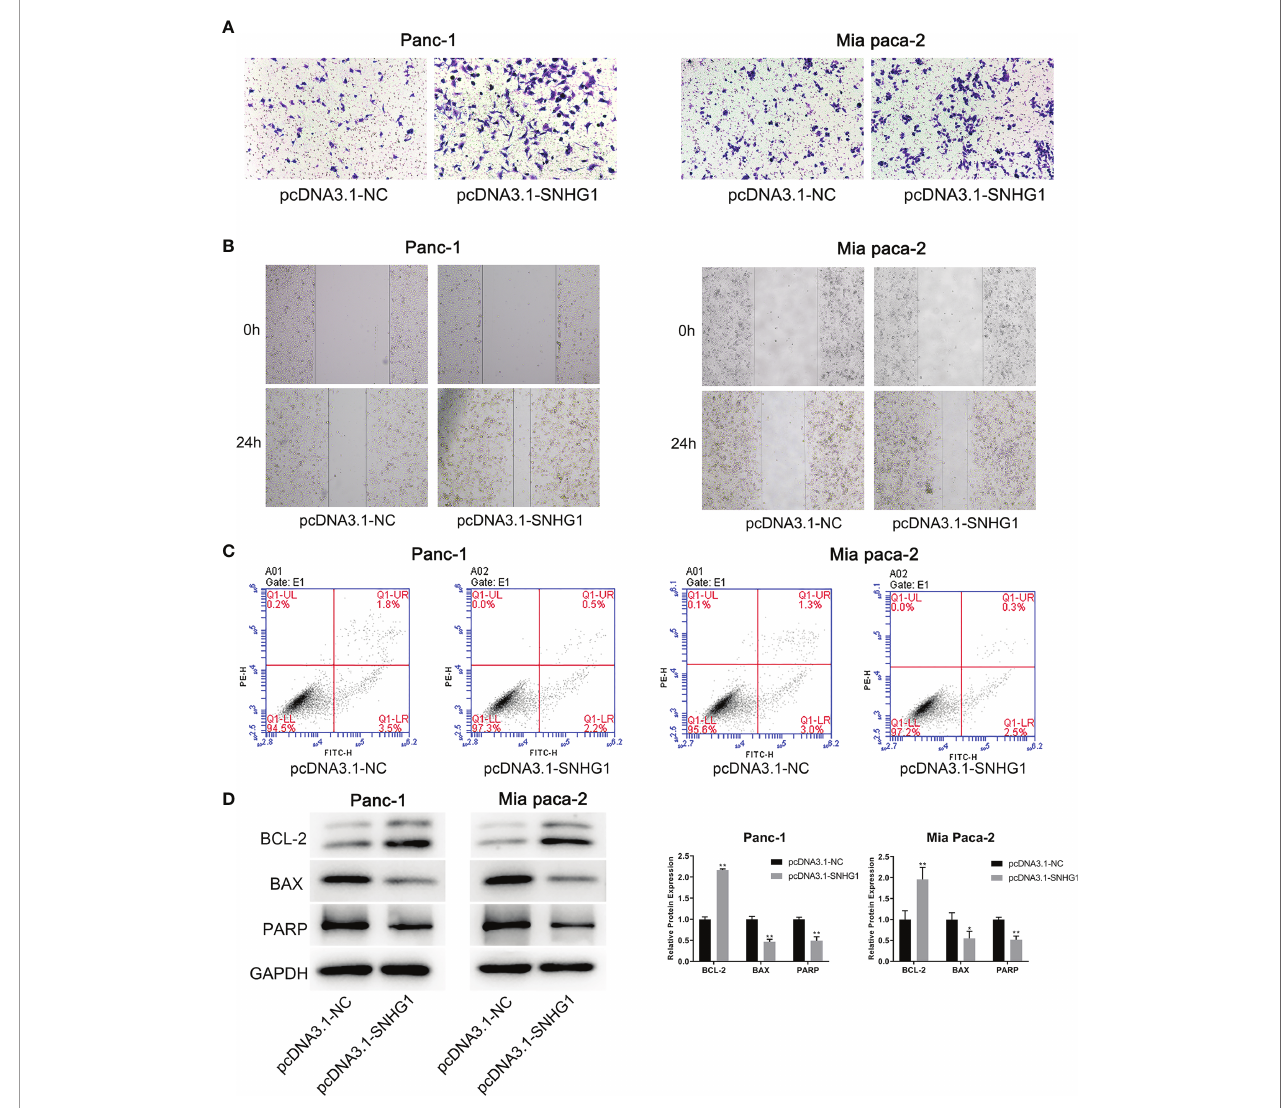
FIGURE 4 | Overexpression of SNHG1 promotes PC cell invasion and migration and inhibits apoptosis. (A, B) Transwell and wound-healing assays demonstrated migration and invasion. (C) Apoptosis was determined by fl ow cytometry. (D) WB showed expression of apoptosis-related proteins. *p < 0.05, **p <